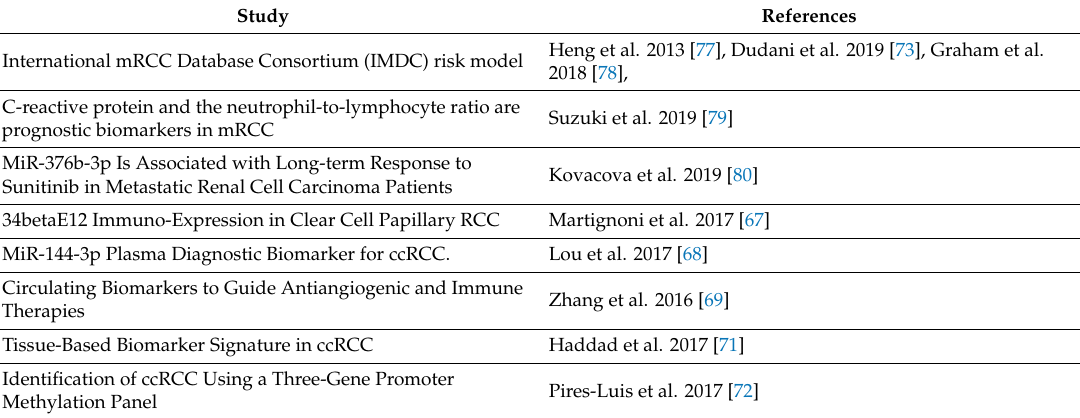
Table 9. Extract of recent updates for biomarkers in